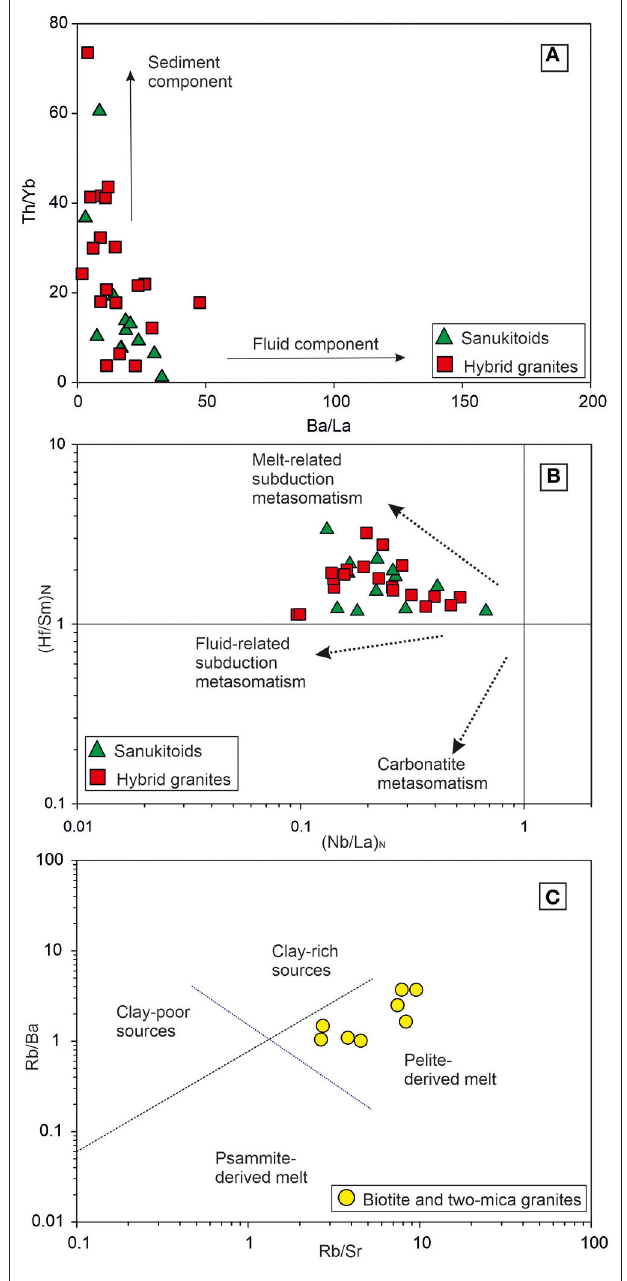
FIGURE 8 | (A) Th/Yb vs. Ba/La plot (Woodhead et al., 2001), to identify the role of sediment and fluid component. (B) (Hf/Sm) N vs. (Nb/La) N plot (La Flèche et al., 1998), to differentiate the metasomatic agent involved in the petrogenesis of Kanker granites (C) Rb/Ba vs. Rb/Sr plot (after Sylvester, 1998), to determine the nature of crustal sediments involved in the petrogenesis of strongly peraluminous biotite and two-mica granites.